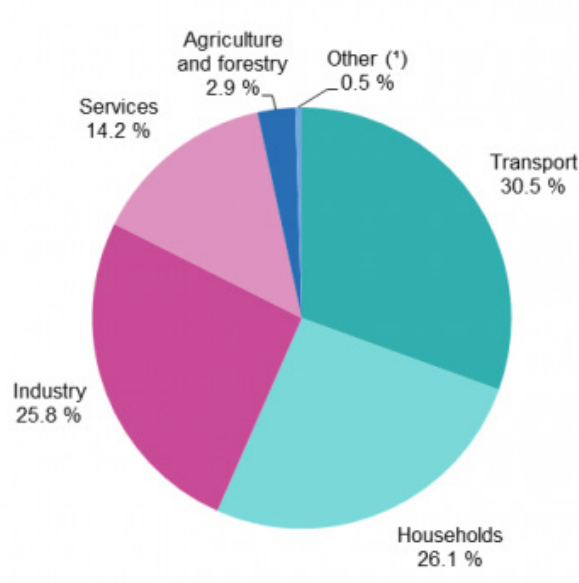
Figure 2: Percentage distribution of energy consumption by sector in 2018